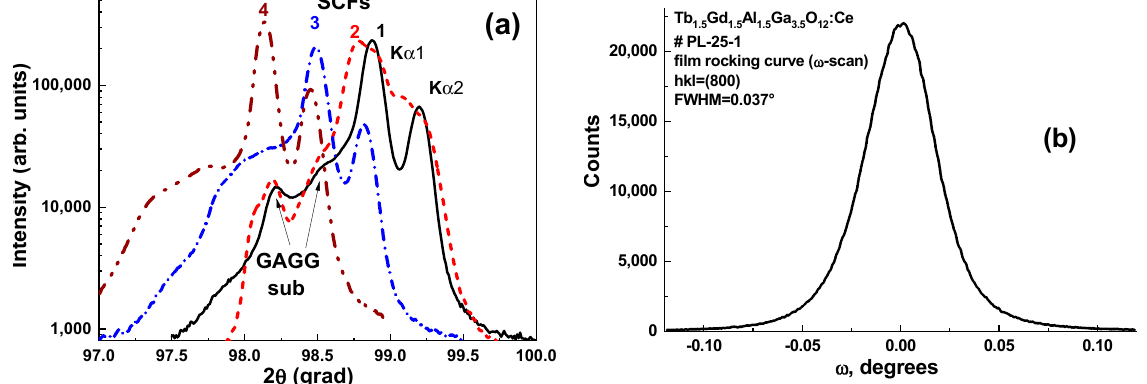
Figure 2. ( a ) XRD patterns of (Tb,Lu,Gd) 3 (Al,Ga)O 12 :Ce SCFs with different nominal contents (1— Tb 3 Al 2.25 Ga 2.75 O 12 :Ce SCF, 24 μ m thickness, misfit Δ a = − 0.49%; 2—Lu 1.5 Gd 1.5 Al 3 Ga 2 O 12 :Ce SCF, 6 μ m, Δ a = − 0.71%; 3—Tb 2 GdAl 1.5 Ga 3.5 O 12 :Ce SCF, 35 μ m, Δ a = − 0.20%; 4—TbGd 2 Al 1.5 Ga 3.5 O 12 :Ce SCF; 125 μ m, Δ a = − 0.54%); ( b ) X-ray rocking curve of Tb 1.5 Gd 1.5 Al 1.5 Ga 3.5 O 12 :Ce SCF, 6 μ m.